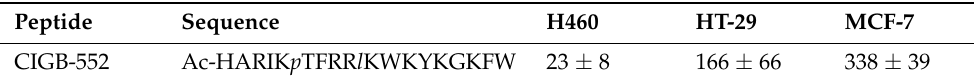
Table 1. CIGB-552 cytotoxicity in H460, HT-29 and MCF-7 cell lines (expressed by the IC 50 value in µ M); D-amino acids are indicated in small and italic